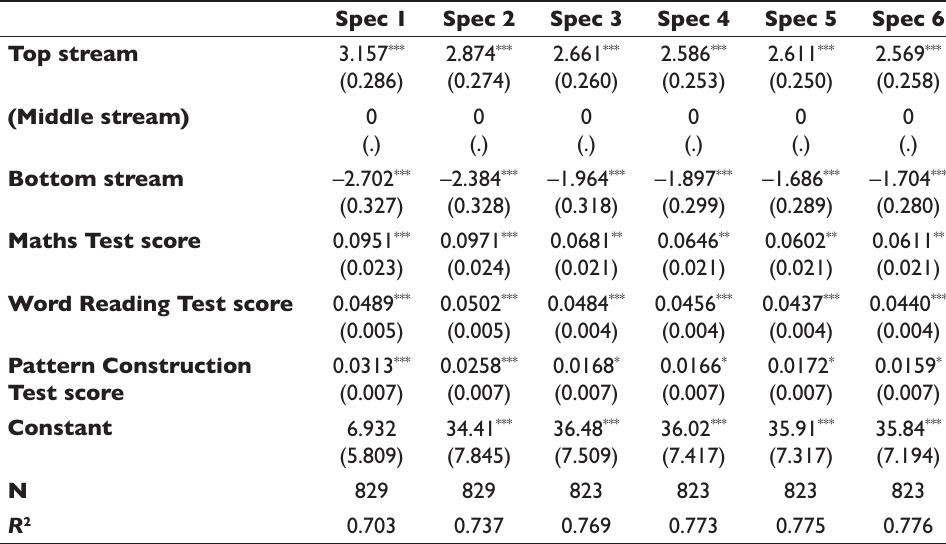
Table 5: Difference in summed survey-reported teacher judgement of ‘ability and attainment’ according to pupils’ stream placement (a)(b)